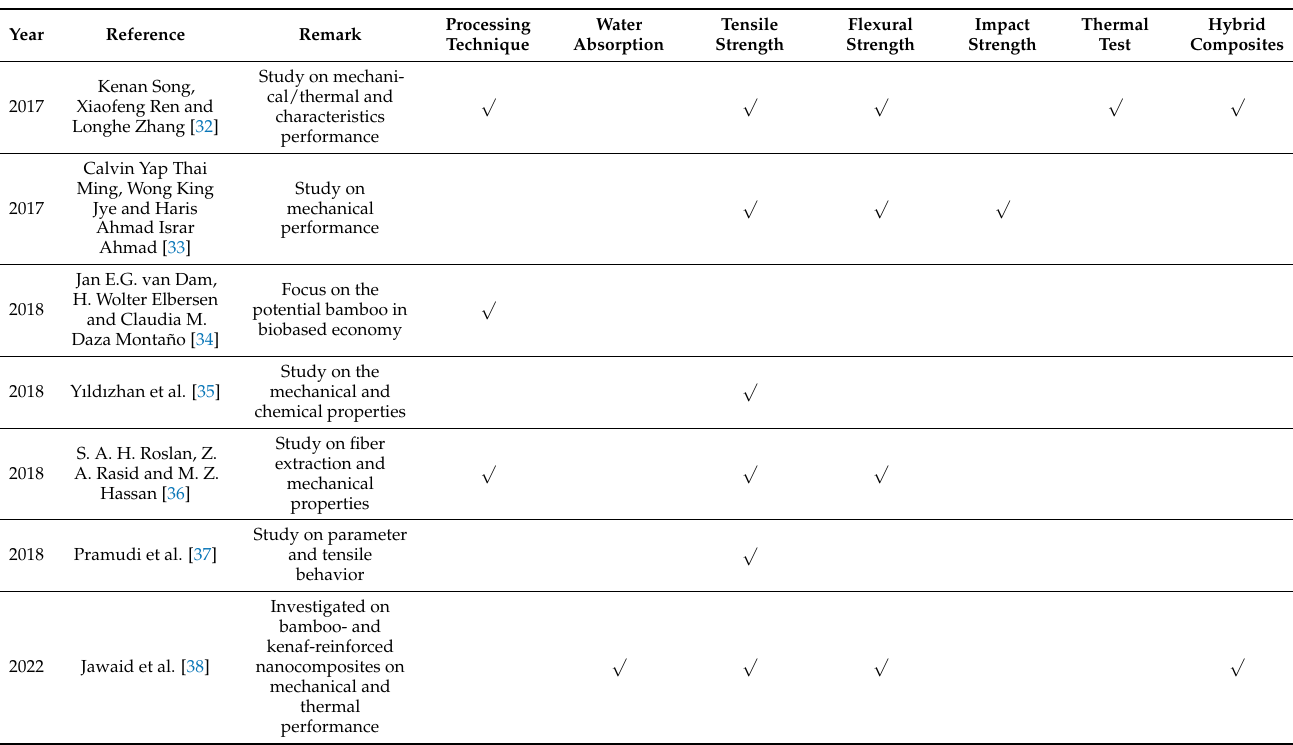
Table 1. Recently review studies in bamboo-based